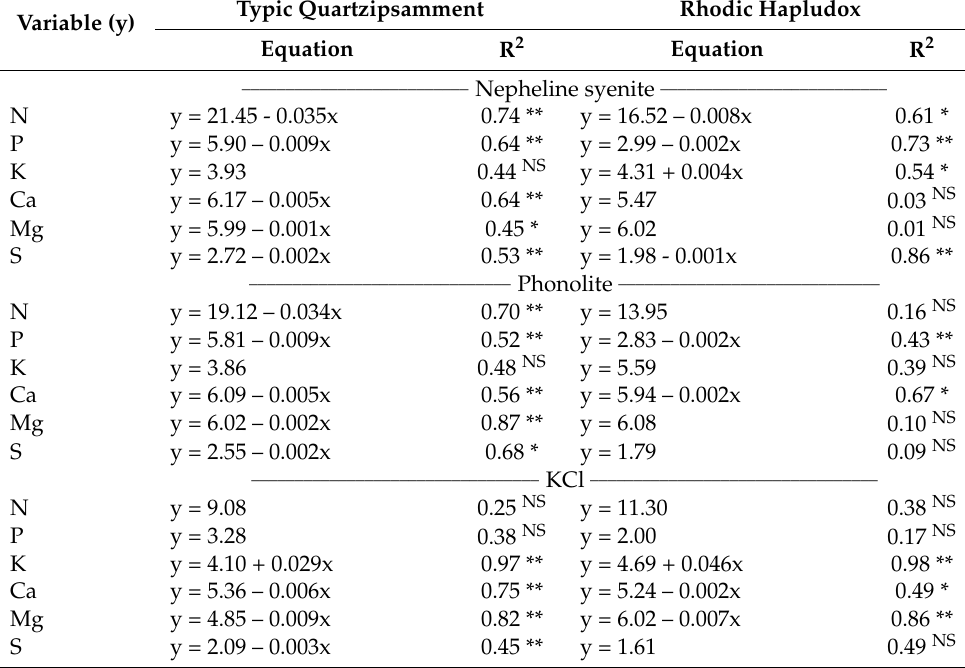
Table 11. Determination coefficients (R 2 ) and regression equations that best fit the relationships between the macronutrient concentration in the shoot of maize plants as a function of the K sources, in the different types of